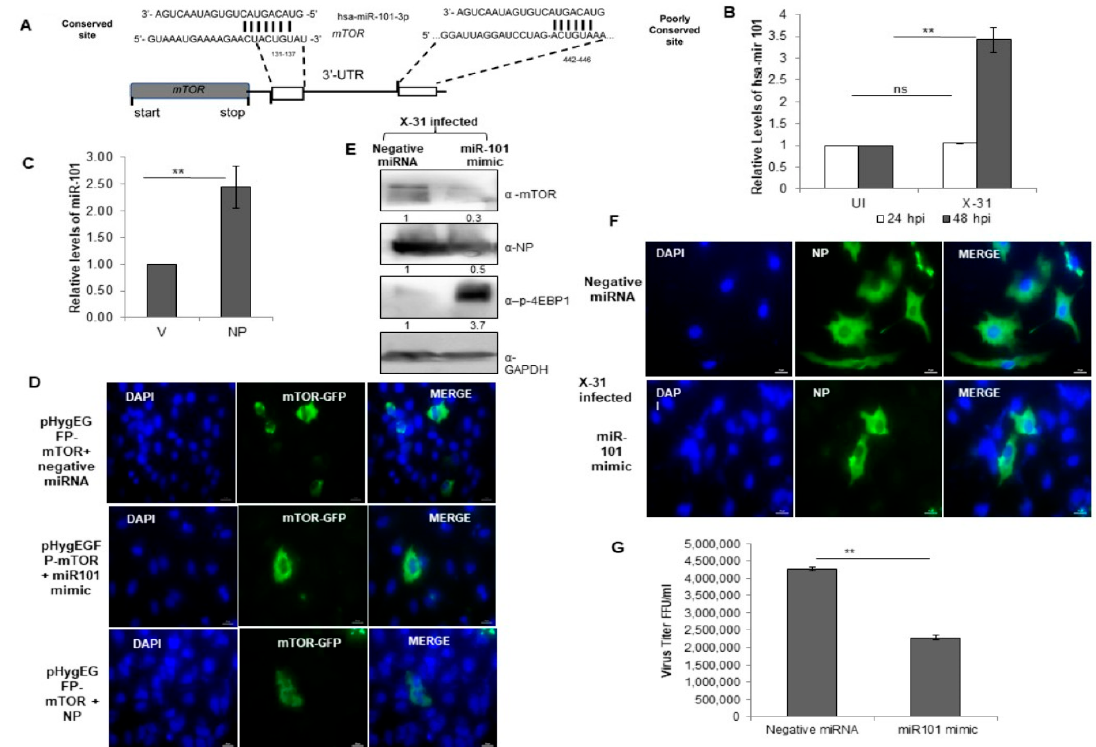
Figure 6. miR-101 is predicted to bind to 3 (cid:48) -UTR of the mTOR gene and upregulated during IAV infection. ( A ) Sequence complementarity between miR-101 seed region with the target site in the 3 (cid:48) UTR of mTOR. ( B ) A549 cells were infected with X-31 at an MOI of 1 and samples were harvested at 24 hpi and 48 hpi. Total RNA was isolated to estimate the miR-101 transcript levels using stem-loop qPCR specific primers. ( C ) A549 cells were transfected with V or with NP for 72 h. Total RNA was isolated for the assessment of the level of miR-101 transcripts by qPCR using specific stem loop primers. ( D ) A549 cells were transfected with 1 µ g pHygEGFP-mTOR that were co-transfected with 50 nM negative control miRNA, 50 nM miR-101 mimic and NP. Nuclei were stained with DAPI (Blue). Numbers of GFP fluorescent cells were counted to evaluate the di ff erence between di ff erent experiments of triplicate determinations. Scale is 20 µ m. ( E ) A549 cells were transfected with 50 nM negative control miRNA or 50 nM miR-101 mimic followed by infection with X-31 at an MOI of 1 for 48 h and the whole-cell lysates from the same samples were resolved on SDS-PAGE for detection of mTOR, NP, p-4EBP1 and GAPDH. ( F ) A549 cells were transfected with 50 nM negative control miRNA or 50 nM miR-101 mimic followed by infection with X-31 at an MOI of 5 for 24 h. The cells were fixed at 24 hpi. NP was detected using goat anti-mouse-antibody conjugated to FITC (green). Nuclei were stained with DAPI (Blue). The percentage of virus-infected cells as determined by NP-expression was enumerated. Scale is 20 µ m. ( G ) A549 cells were transfected with 50 nM negative control miRNA or 50 nM miR-101 mimic followed by infection with X-31 at an MOI of 1 for 48 h followed by determination of viral titers by flow cytometry analysis with anti-NP antibody conjugated to Alexa Fluor 488. The data in B, C and G is shown as mean ± S.D. of three independent experiments. ** indicate statistically significant di ff erences at p < 0.01. ns denotes